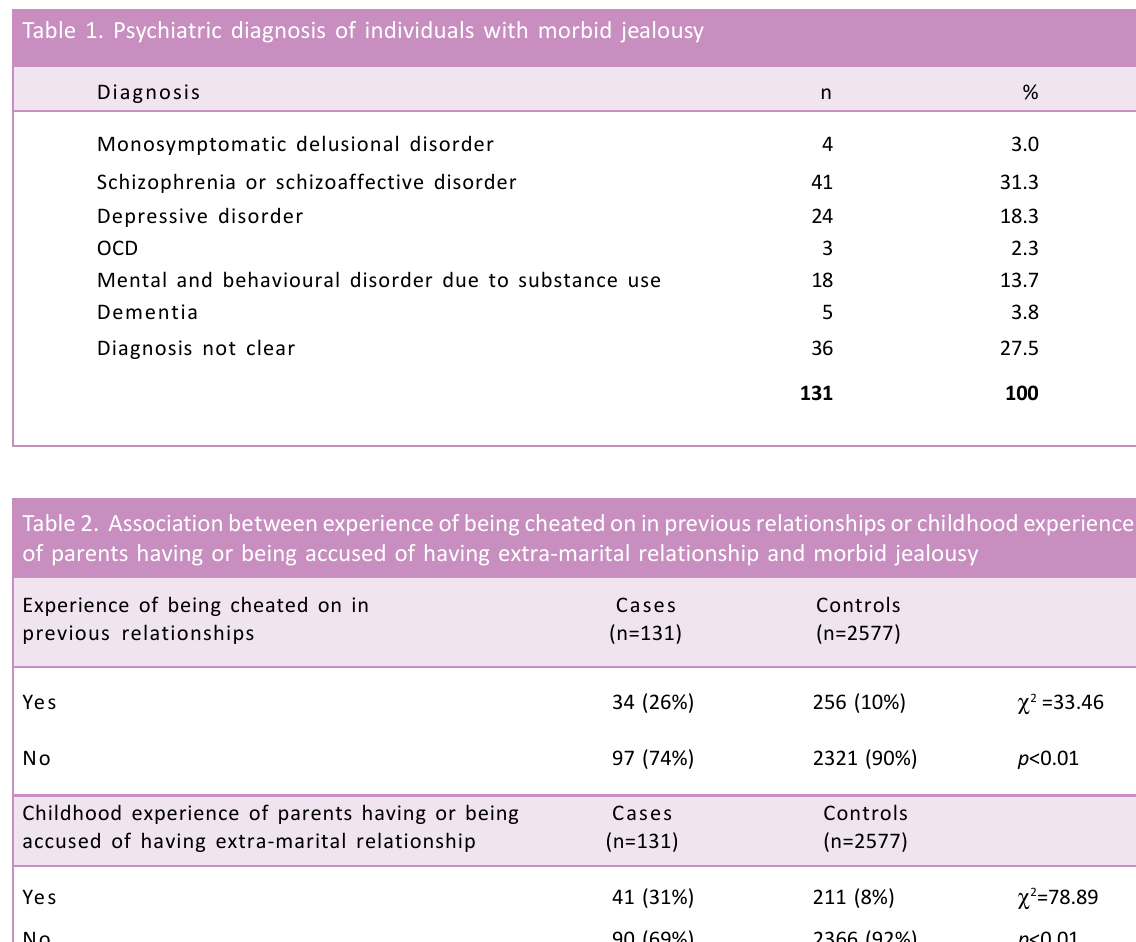
Cases – patients with morbid jealousy; Controls – patients without morbid jealousy; χ 2 = chi square